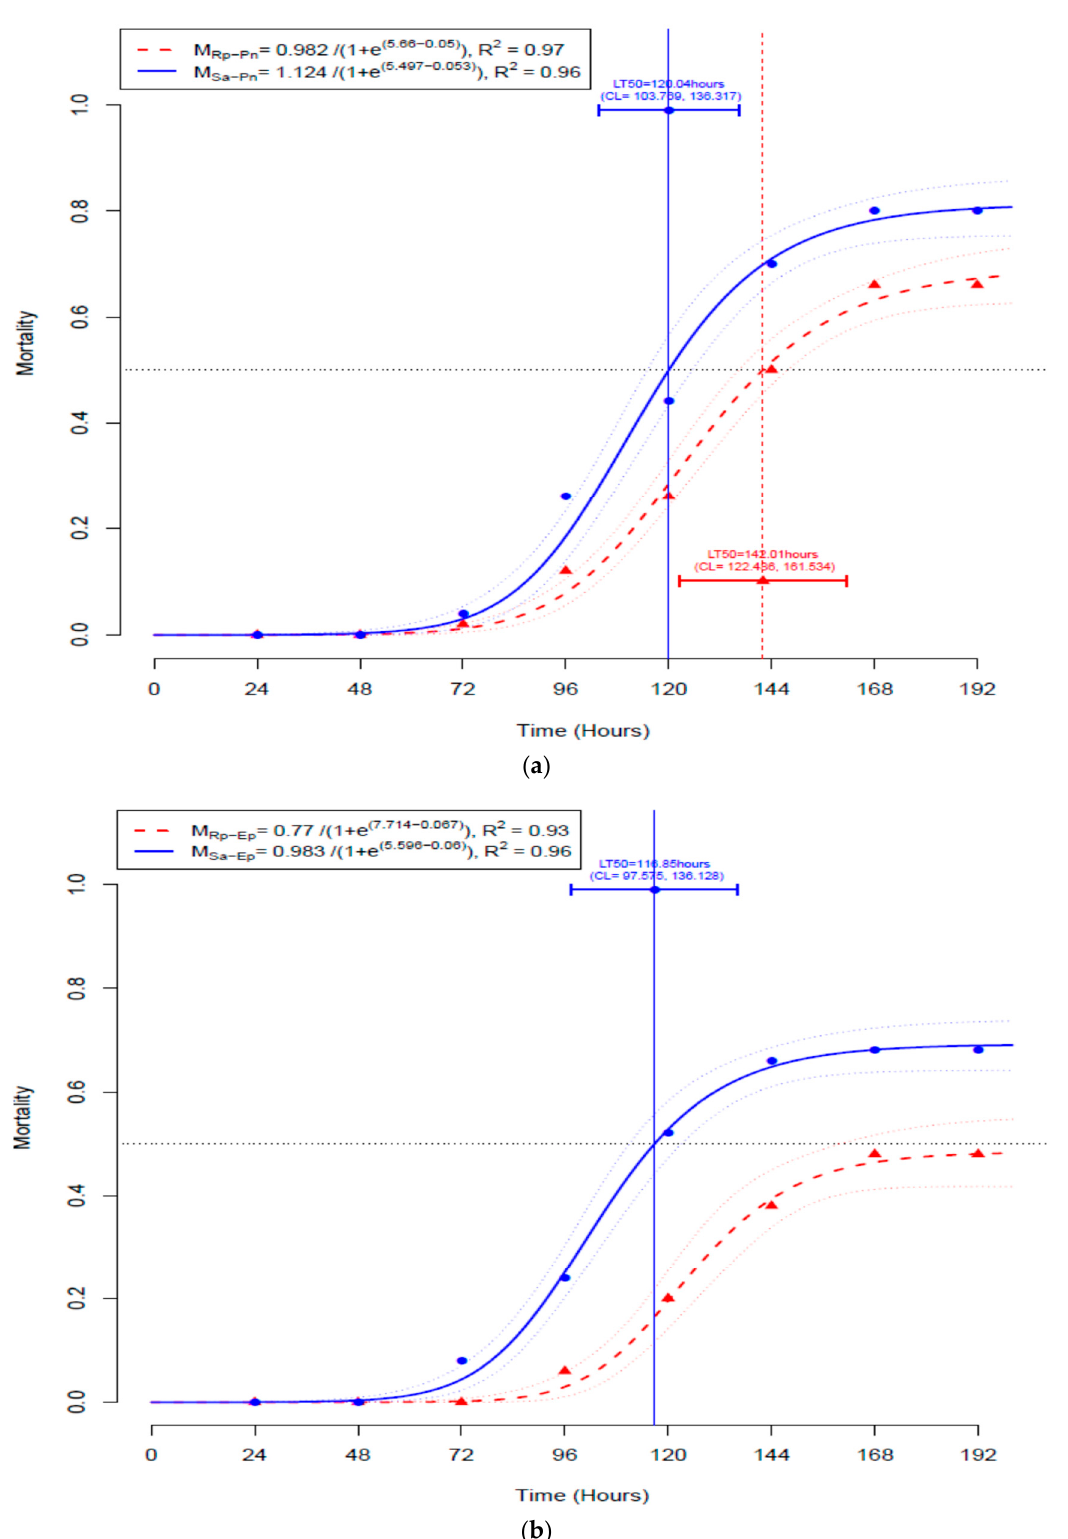
Figure 2. Time–mortality of fungus infected aphids. ( a ) Sitobion avenae (M Sa-Pn ) and Rhopalosiphum padi (M Rp-Pn ) infected with Pandora neoaphidis . ( b ) Sitobion avenae (M Sa-Ep ) and Rhopalosiphum padi (M Rp-Ep ) infected with Entomophthora planchoniana.